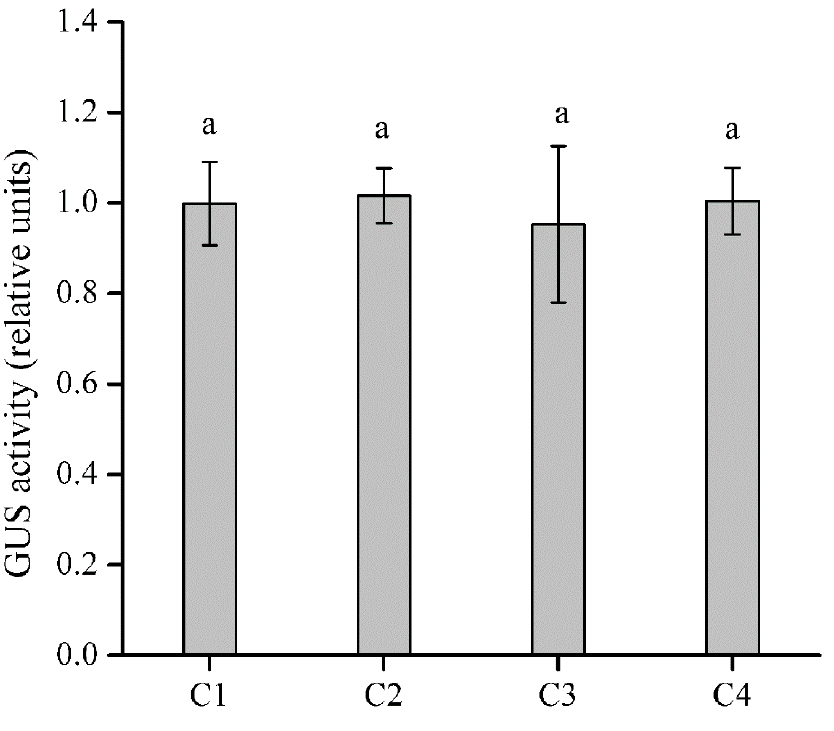
Figure 6. Relative GUS activity of transgenic Arabidopsis harboring 5 ′ -deletion promoter constructs under 100 μ M SA treatment. The 5 ′ -deletion promoter constructs were C1 ( − 1460 to ATG), C2 ( − 729 to ATG), C3 ( − 612 to ATG), and C4 ( − 209 to ATG). Relative GUS activity was calculated as the activity of the treated transgenic line divided by the activity of its untreated control. Bars represent the mean ± SD, and different letters indicate significant differences ( p < 0.05) based on Duncan’s test ( n = 3).